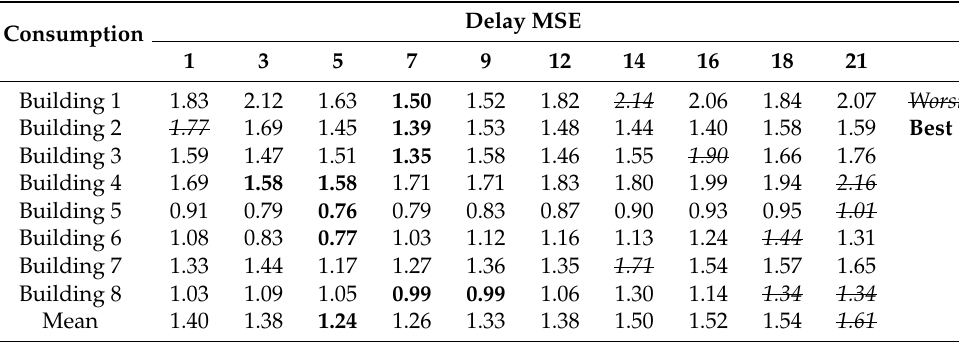
Table 3. MSE of the delay parameter obtained with the NARX